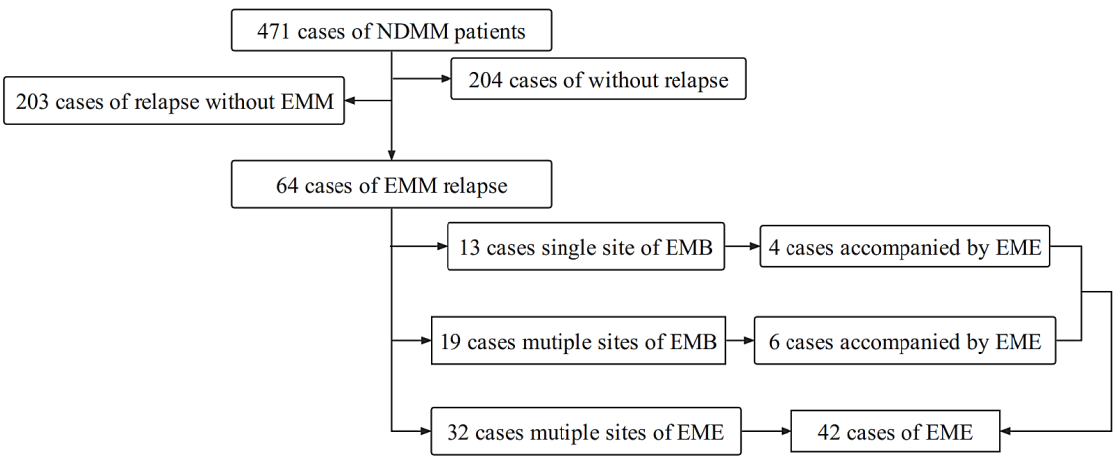
Figure 1. Schematic diagram of EMM patient detection. Compared with patients without any relapse during follow-up, patients with ex- tramedullary relapse were more common in IgD subtype (12.7% vs. 1.5%, p < 0.001), more inclined to R-ISS stage 3 (45.5% vs. 29.1%, p = 0.025), more likely to have decreased platelet (Plt) levels (46.0% vs. 27.9%, p = 0.007), higher serum lactate dehydrogenase (LDH) levels (39.7% vs. 14.2%, p < 0.001), spleen enlargement (40.6% vs. 16.2%, p < 0.001), osteolytic lesions (50.0% vs. 13.2%, p < 0.001)and extramedullary involvement (50.0% vs. 20.6%, p < 0.001) (Table 1). Compared with patients with relapse but without extramedullary involvement during follow-up, patients with extramedullary relapse were more likely to have higher serum LDH levels (39.7% vs. 21.1%, p = 0.003), hypercalcemia (50% vs. 33.2%, p = 0.012), spleen enlargement (40.6% vs. 23.2%, p = 0.012), osteolytic lesions (50.0% vs. 15.2%, p < 0.001) and extramedullary involvement (50.0% vs. 17.7%, p < 0.001) (Table